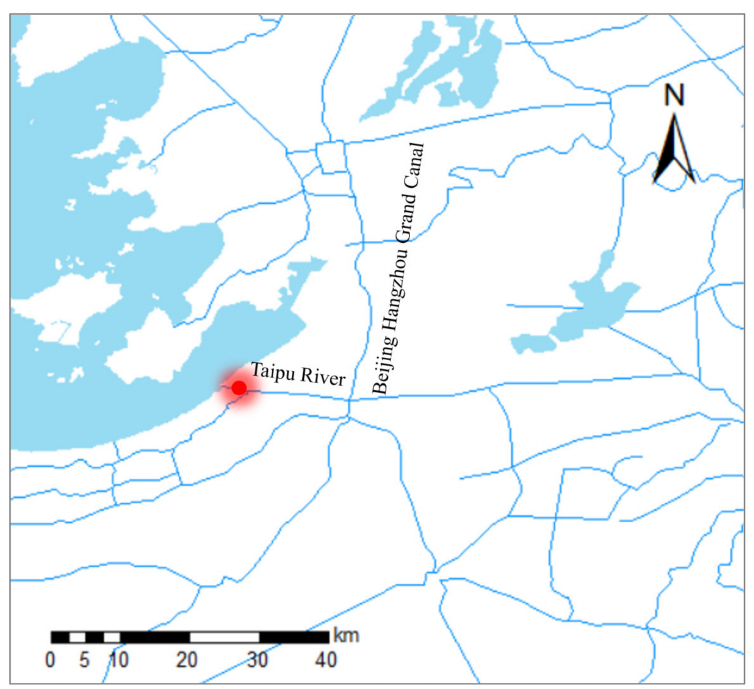
Figure 5. Map of the oil spill location in the upper reaches of the Taipu River. The simulated oil spill indicated that the maximum thickness of the oil film decreased from 1.94 mm to 0.48 mm from the location of the spill to the end of the Taipu River. The diffusion and drift processes of the oil film in the Taipu River are shown in Figure 6.